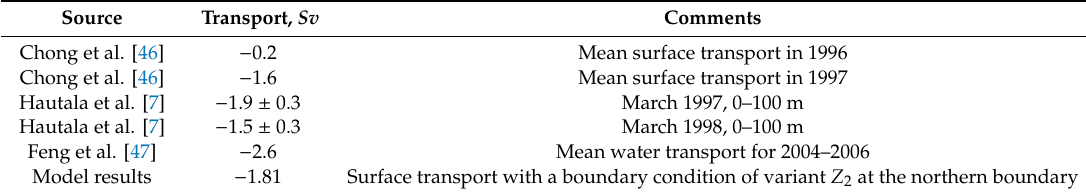
Table 1. Transport across Lombok Strait. Negative values indicate flow toward the Indian Ocean. Source Transport,